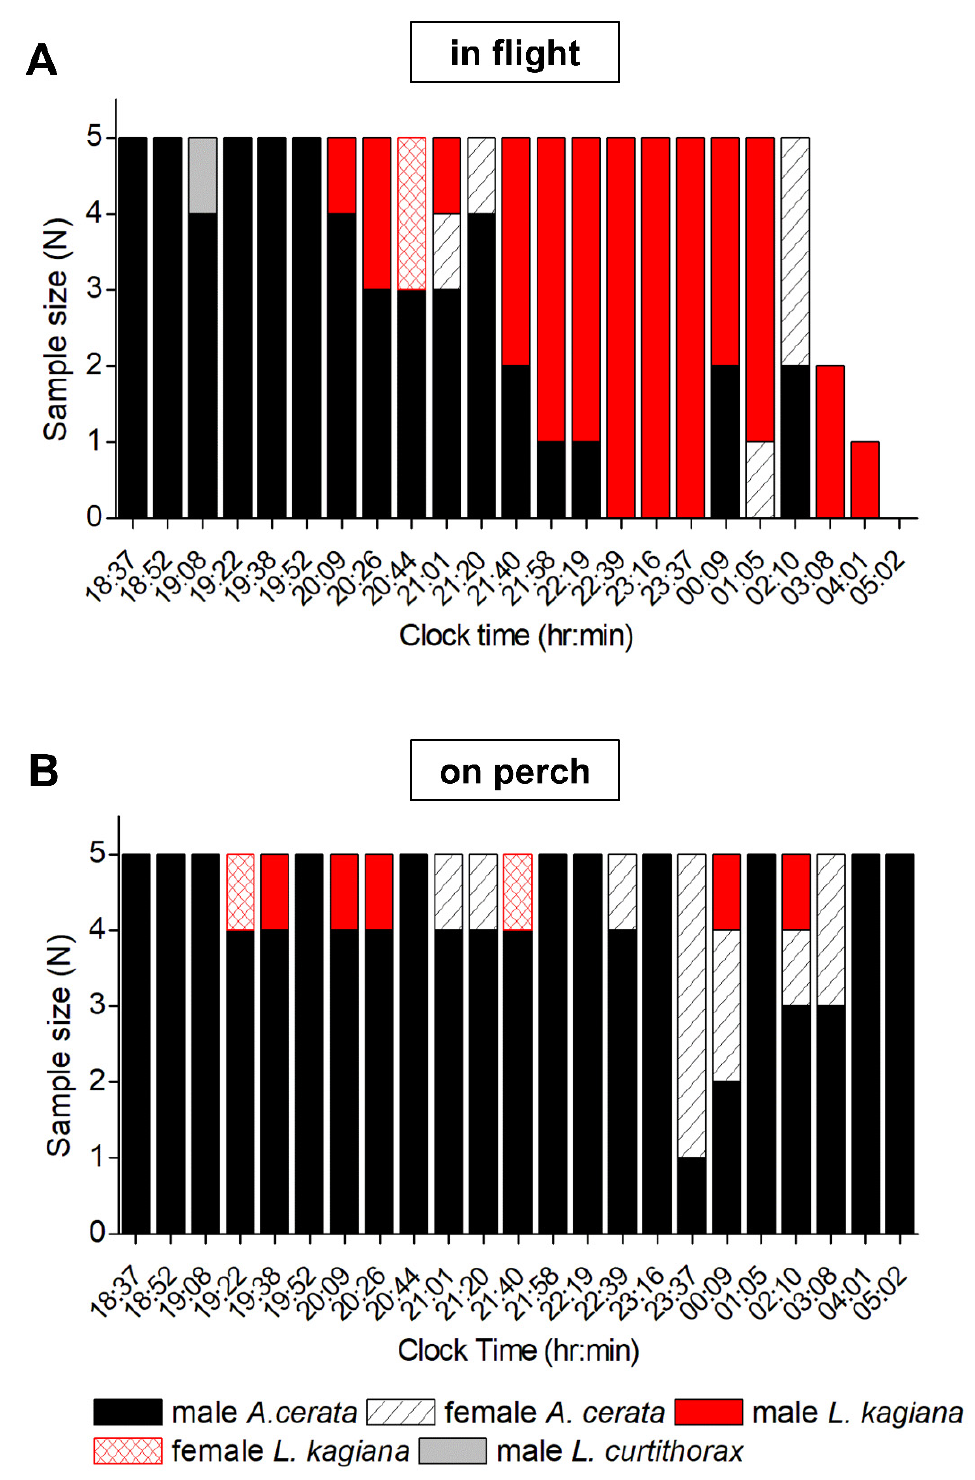
Figure 6. Time-course collection of flying and perching fireflies along the Genliao hiking trail. The nightly harvesting ratio of males or females of A. cerata , L. kagiana , and L. curtithorax while flashing ( A ) in flight and ( B ) on perch are shown. Five specimens in flight and five on a perch were collected every 15 or 60 min from 18:30 on 21 April to 05:01 on 22 April 2018. Morphological identifications of species and sex for collected specimens are described in Materials and Methods.